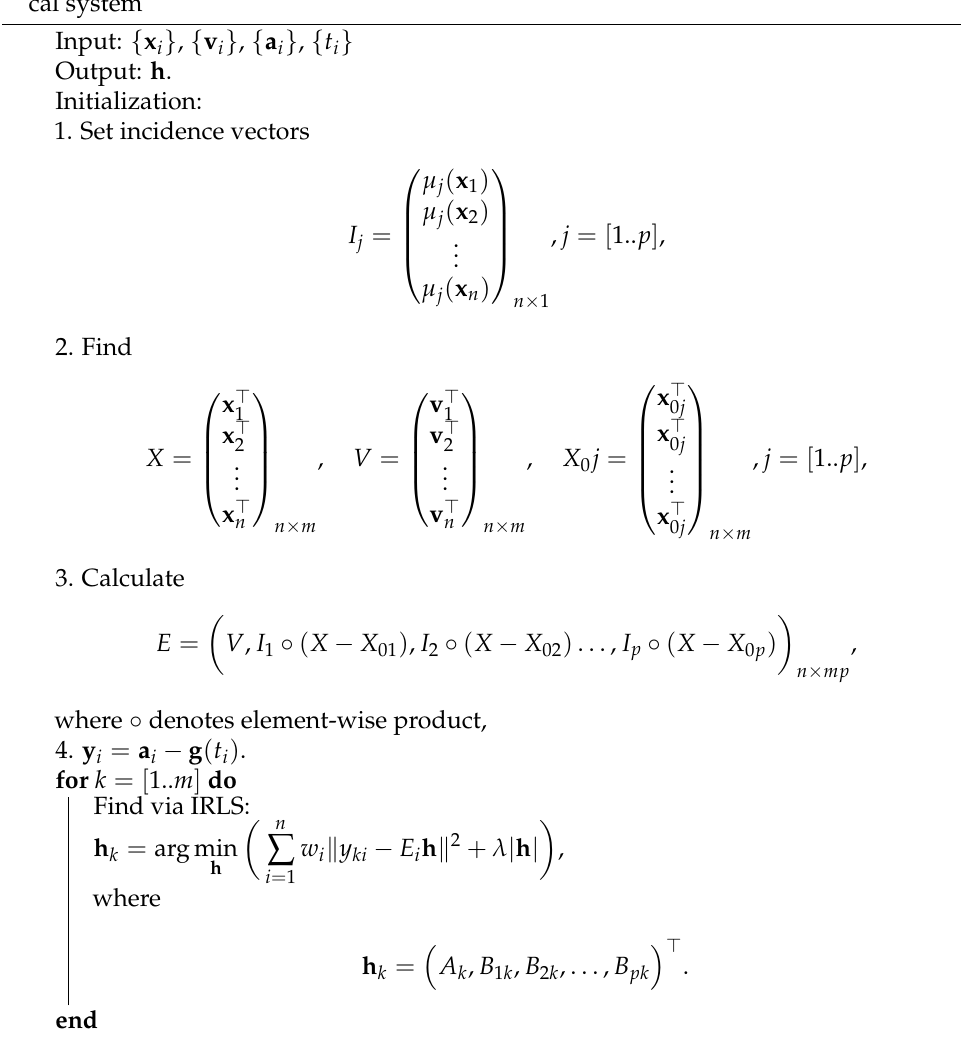
Algorithm 2 outlines system identification via DIA. Algorithm 2: DIA for parametric identification of piece-wise linear mechani- cal